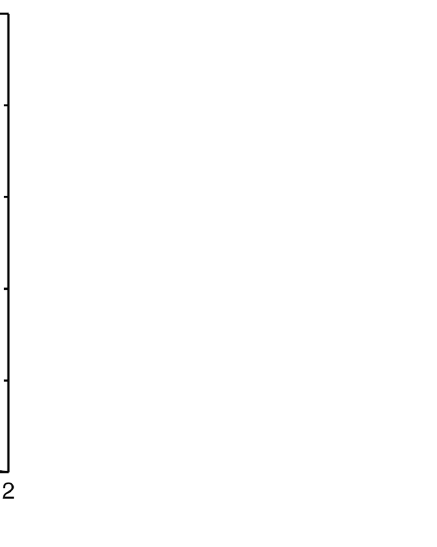
Fig. 8. Pressure drop in cuffed vessels. Plot of pressure at the arterial wall versus distance down the carotid of a mouse with the cuff in the conventional direction. Flow direction, cuff location and cuff orientation are indicated as described for Fig. 2. Pressure is expressed relative to the pressure 2 mm downstream of the end of the cuff. Values were derived from CFD simulations that used the different inflow velocities shown in the first row of Table S1 in S1 File. The blue line is the case for v 5 12